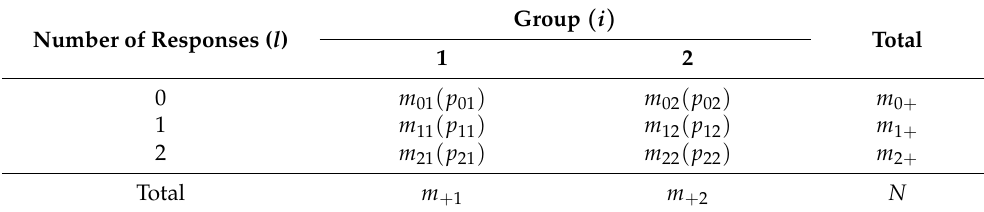
Table 1. Data structure for bilateral binary